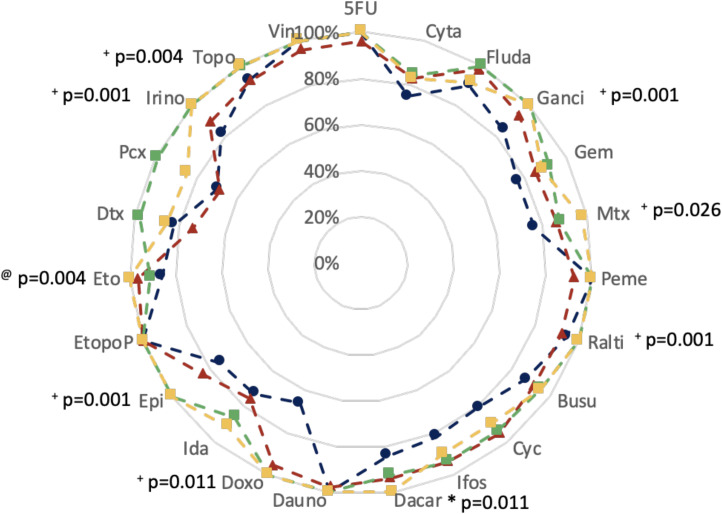
Comparison of the decontamination efficiency per contaminant of four decontamination or deactivation solutions after vigorous decontamination.Values represented are median Effq for each drug (n = 6). 5FU: 5-fluorouracil; Cyta: cytarabine; Fluda: fludarabine; Ganci: ganciclovir; Gem: gemcitabine; Mtx: methotrexate; Peme: pemetrexed; Ralti: raltitrexed; Busu: busulfan; Cyc: cyclophosphamide; Ifos: ifosphamide; Dacar: dacarbazine; Dauno: daunorubicin; Doxo: doxorubicin; Ida: idarubicin; Epi: epirubicin; EtopoP: etoposide phosphate; Eto: etoposide; Dtx: docetaxel; Pcx: paclitaxel; Irino: irinotecan; Topo: topotecan; Vin: vincristine. Blue line/circles: 70% isopropanol; red line/triangles: admixture of ethanol-hydrogen peroxide (91.6–50.0 mg/g); green line/diamonds: admixture of 10−2 M sodium dodecyl sulfate/isopropanol (80/20) and yellow line/squares: sodium hypochlorite. + significant difference for both solutions 3 and 4 compared to others.; @ significant differences between the 4 solutions; * significant difference of solution 4 over other solutions.